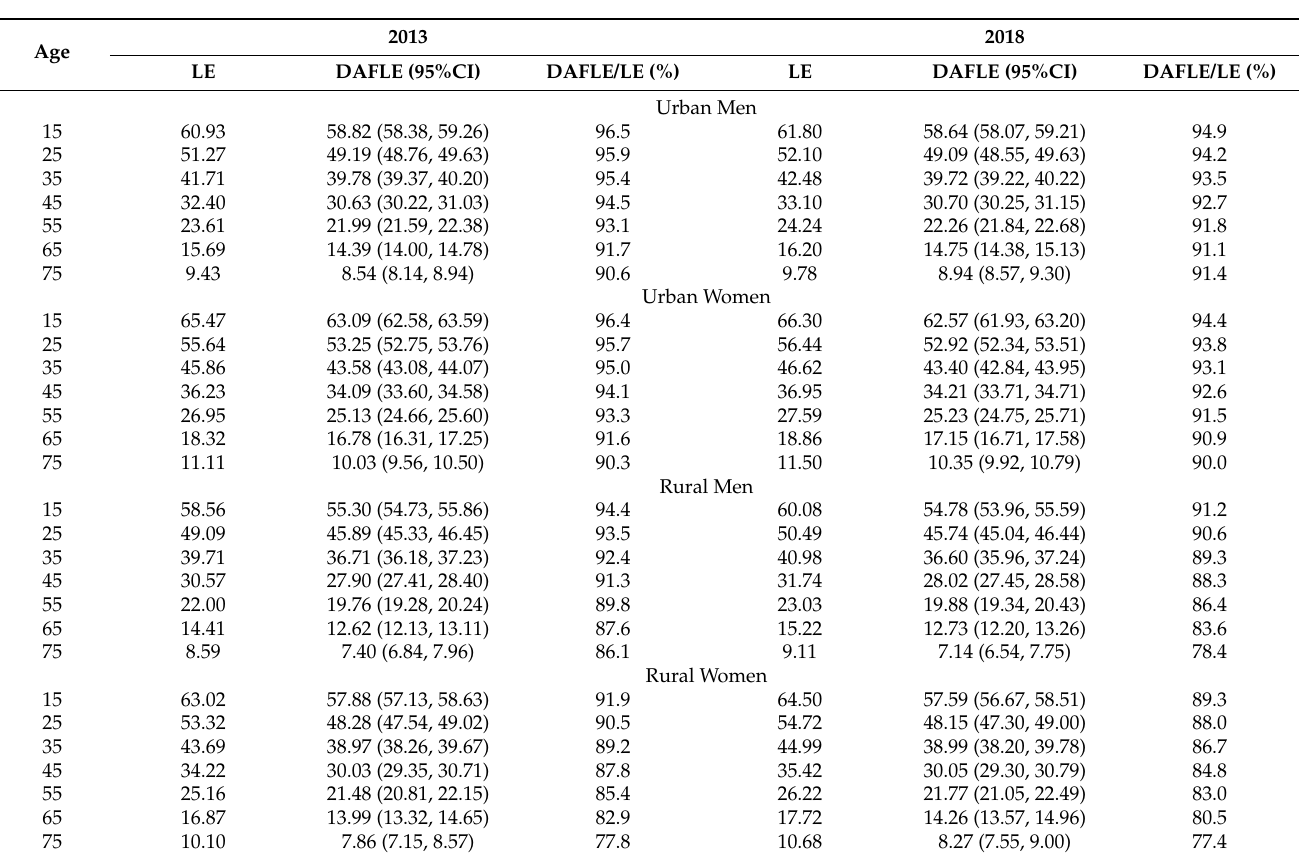
Table 2. LE, DAFLE and the proportion of DAFLE for various ages in urban-rural areas.